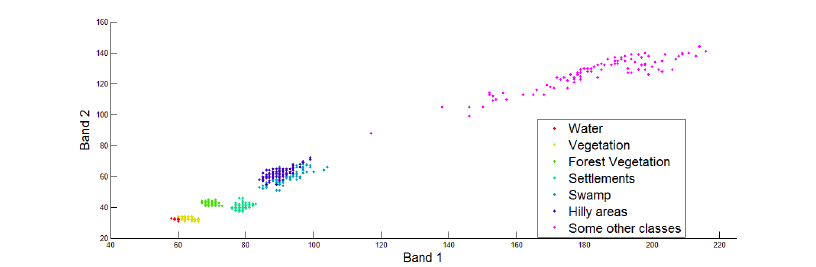
Figure 2: The scatter plot of the test samples with reference labels for the IRS data